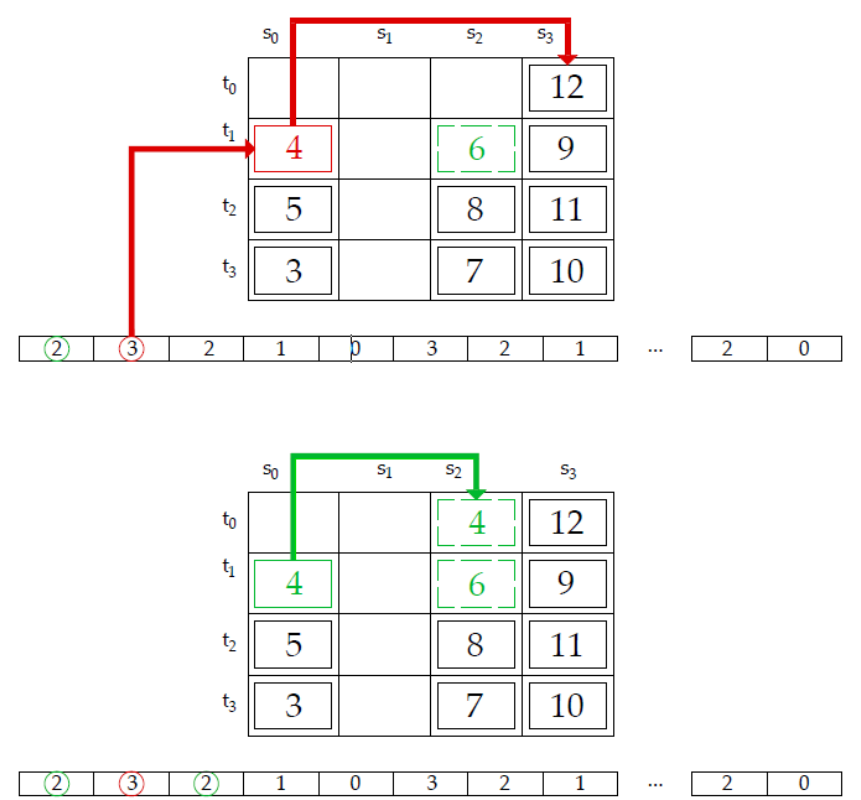
Figure 6. The relocation of container 4 with an example of a fully occupied stack.